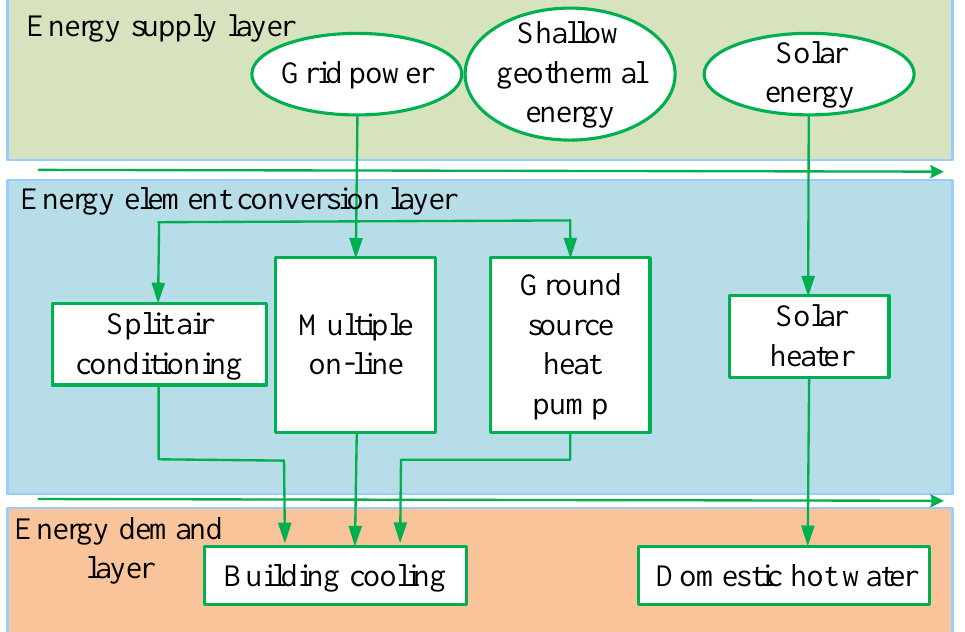
Figure 3. Flow diagram of cooling network for ordinary residential buildings. The elements in the energy supply layer can be referred to as X , the elements in the energy conversion layer can be referred to as V , and the elements in the energy demand layer can be referred to as Y , and artificial sinks t and artificial sources can be added t . The summer regional building energy planning model is shown in Figure 4. The energy planning model constructed in Figure 4 illustrates all possible energy allocation scenarios. Each energy supply, conversion and demand form in the model corresponds to a node in the network, each directed segment corresponds to an arc in the network, and each directed segment corresponds to an arc in the network. The energy flow in the directed channel segment corresponds to the arc capacity in the network, and there is also an energy consumption per unit flow in each directed channel segment, corresponding to the cost in the network.